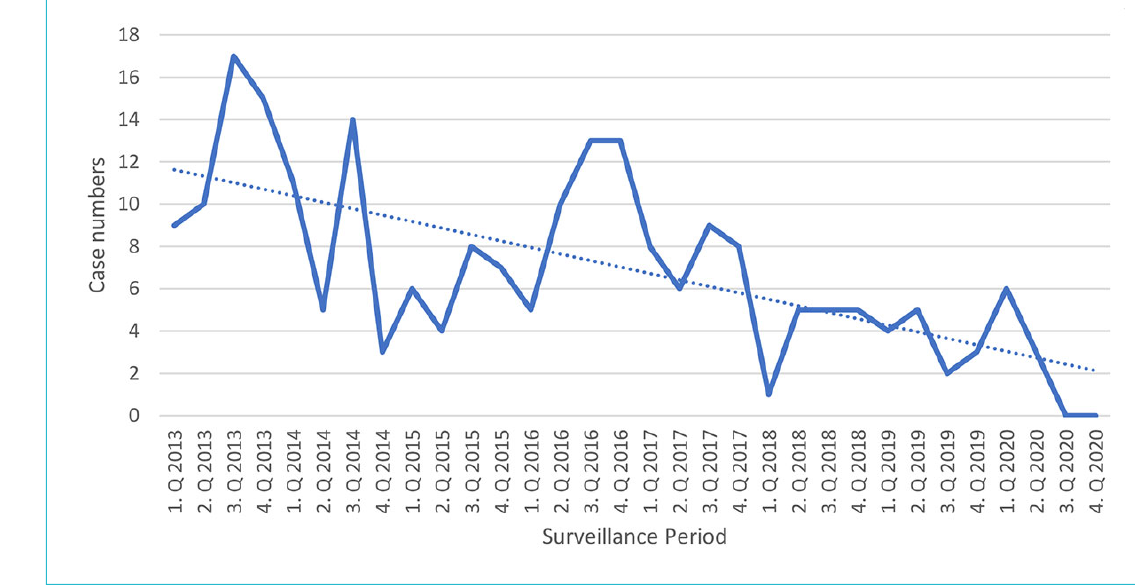
Figure 2: Seasonal variations in incidence by quarter (for 95% confidence intervals see table